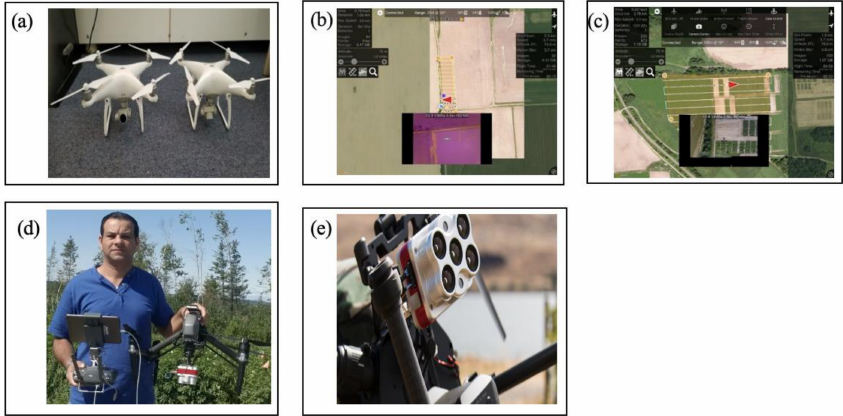
Figure 1. ( a ) The two DJI Phantom 4 UAVs used in 2018. ( b ) Drone flight with a NIR camera. ( c ) Drone flight with an RGB camera. ( d ) DJI Inspire 2 drone and the Altum sensor. ( e ) The Altum